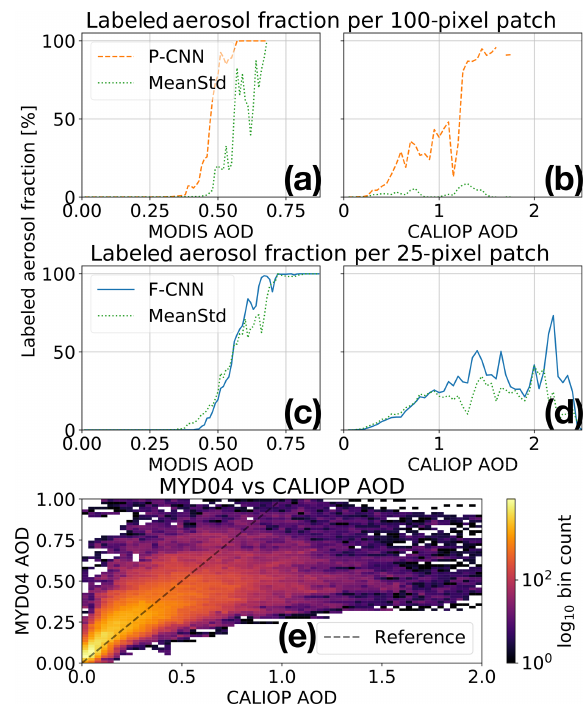
Figure 12. Panels (a) to (d) show the average fraction of aerosols detected in the intersection by the different methods of the proposed methodology for the patches that intersect with the CALIPSO satel- lite track and either the MODIS MYD04 or the CALIOP aerosol products that indicated there were aerosols present in the complete intersection without any clouds. Panels (a) and (c) show the aerosol fraction versus MODIS MYD04 aerosol optical depth (AOD), and panels (b) and (d) show the aerosol fraction versus CALIOP AOD, where panels (a) , (b) and (c) , (d) are specific to the methods of patch sizes 100 and 25 pixels, respectively. Panel ( e) gives insight as to why the aerosol identification sensitivities relative to MODIS (a, c) and CALIOP (b, d) differ; e.g., for a MYD04 AOD of 0.5, the cor- responding CALIOP AOD ranges between 0.25 and